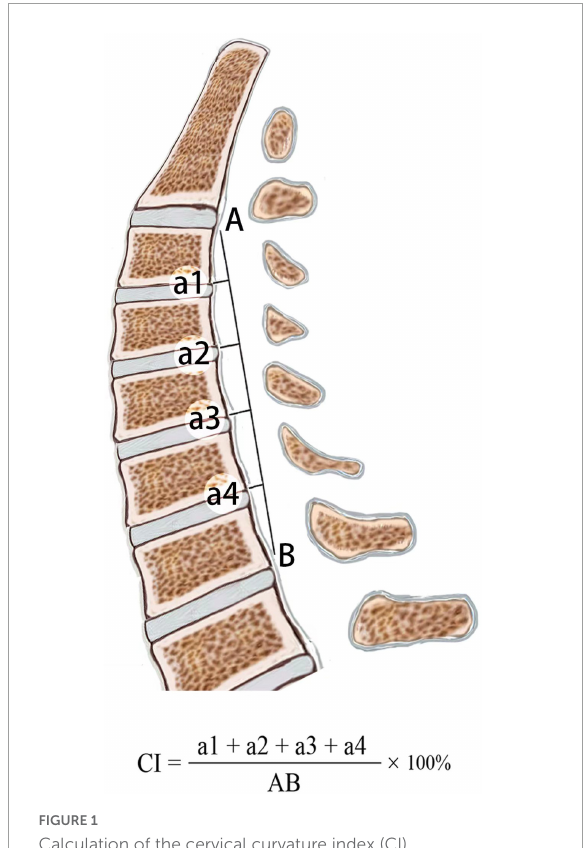
FIGURE1 Calculation of the cervical curvature index